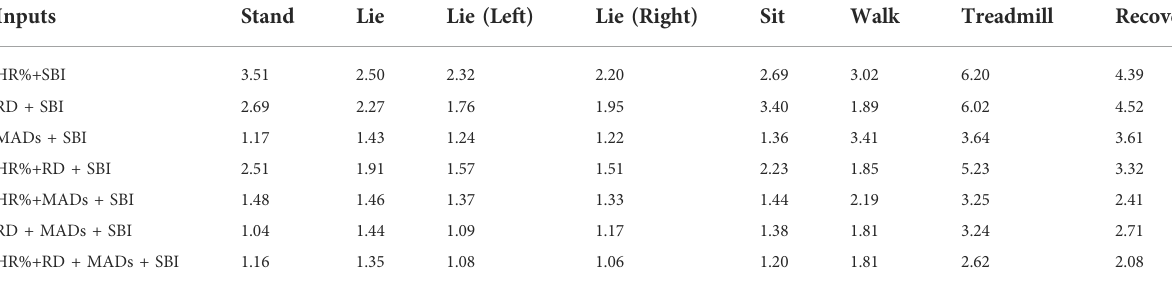
TABLE 5 The results of different input schemes for XGBoost model in various tasks. Inputs Stand Lie Lie (Left) Lie (Right)